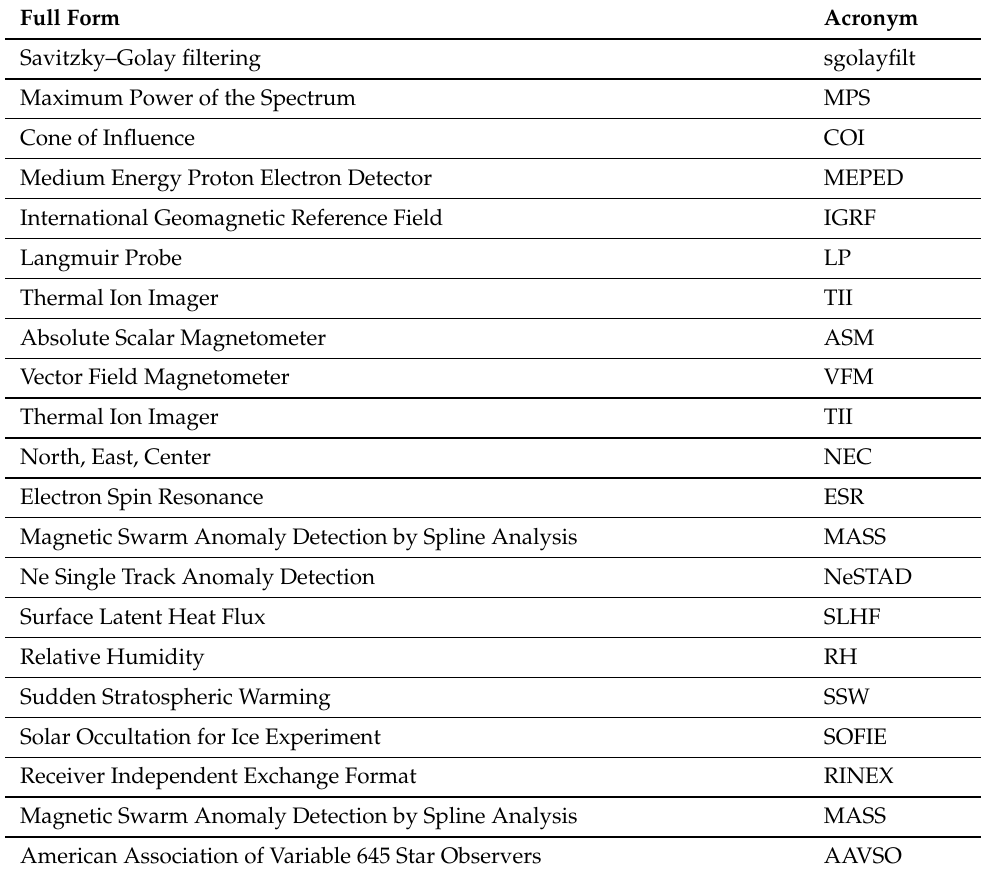
Table 1. Cont. Full